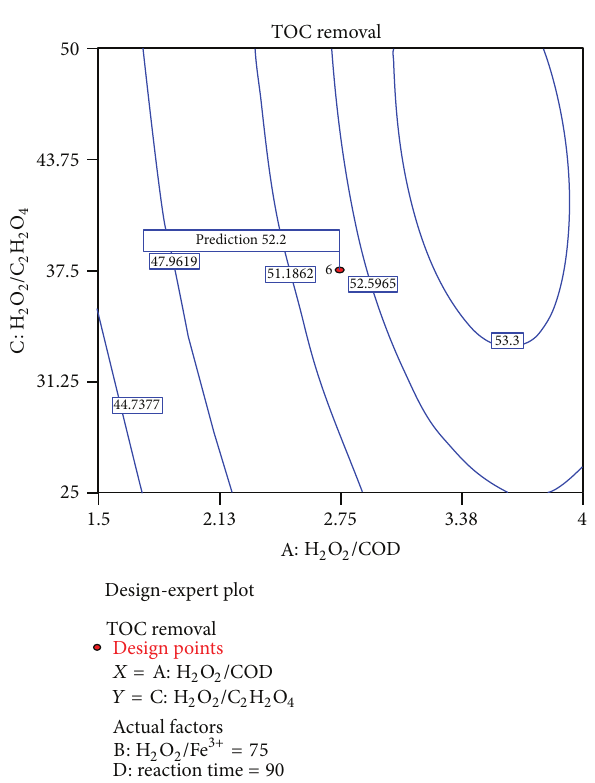
Figure 4: Contour plot for TOC